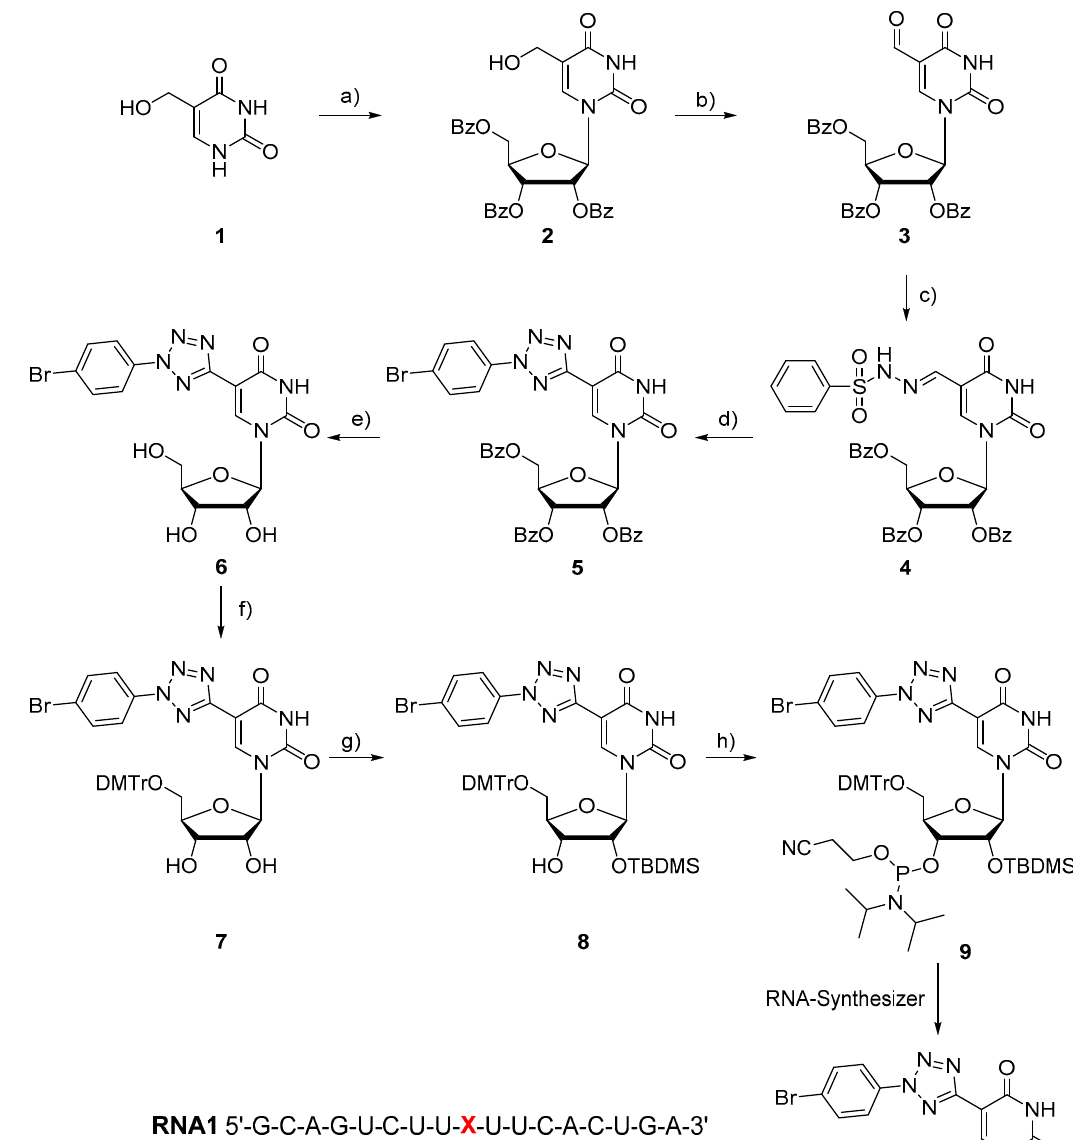
Scheme 1. Synthesis of RNA building block 9 : ( a ) 2,3,5-Tribenzoyl- β